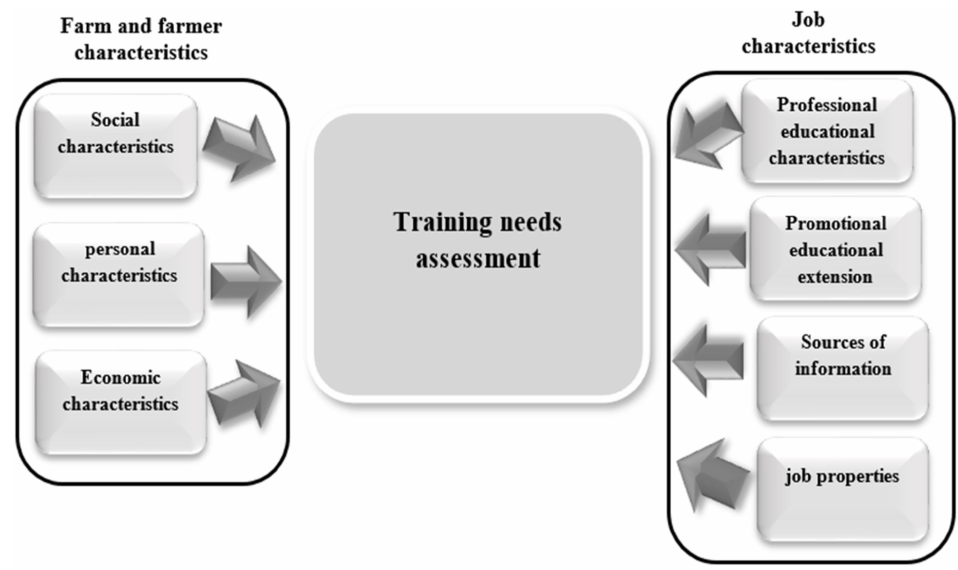
Figure 1. Theoretical model of training needs assessment of female paddy farmers taken from